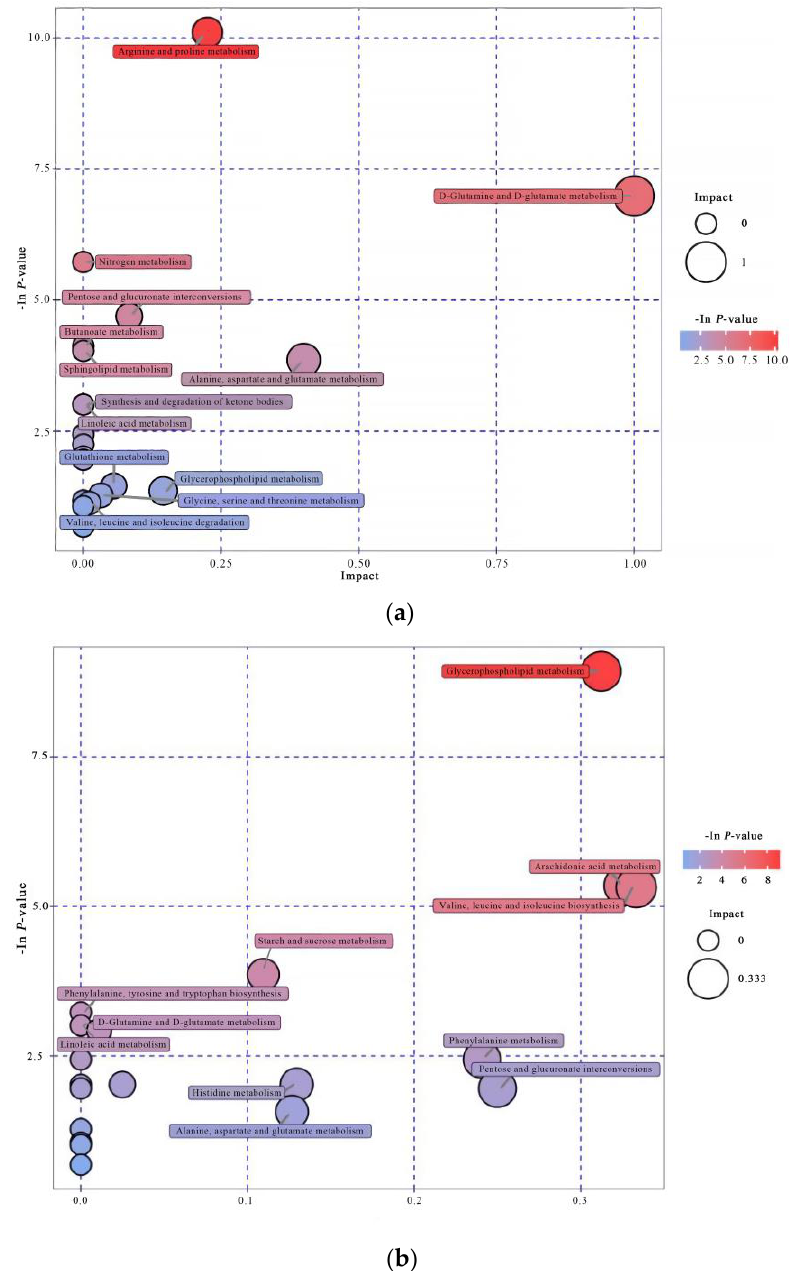
Figure 2. Bubble diagrams of serum ( a ) and follicular fluid ( b ) samples. The position and size of the bubble on the abscissa is the size of the influence factor of the path in the topological analysis. The larger the bubble, the greater the influence factor. The position and color of the bubble on the ordinate is the p -value in the enrichment analysis (-ln p -value, i.e., negative natural logarithm); the smaller the p -value, the darker the color, and the more significant the enrichment.